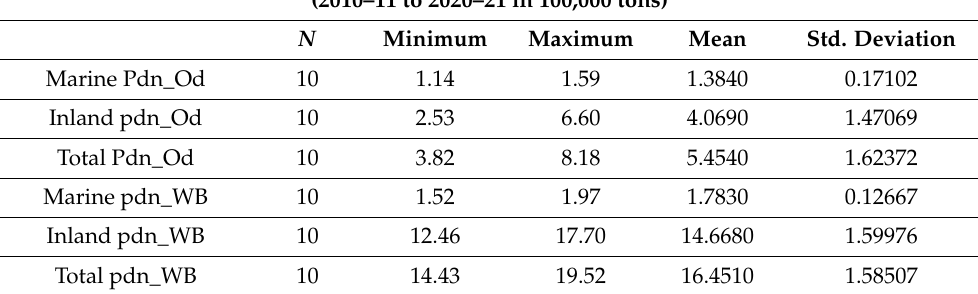
Table 2. Production Dynamics of Marine and Inland Fisheries in the Study